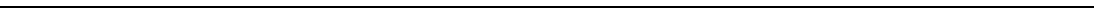
Figure 5 | The AURKA biosensor activates during the G1 phase and at mitosis. ( a ) Representative immunocytochemical images of GFP-AURKA- mCherry U2OS cells synchronized in the indicated cell cycle phases. The fluorescence of EGFP was used to visualize AURKA, centrosomes were labelled with CETN1-iRFP670. N, nucleus. ( b ) Quantification of the fluorescence intensity of EGFP in GFP-AURKA and GFP-AURKA-mCherry cells synchronized in G1 phase, S phase and at mitosis. The fluorescence intensity of both proteins at mitosis was arbitrarily set at 100% and it was used to normalize the fluorescence intensities of EGFP in the other conditions. n ¼ 40–50 cells per condition from three independent experiments. Data represent means ± s.e.m. ( c ) (Left panels) Representative fluorescence (GFP channel) and lifetime images of GFP-AURKA-mCherry cells and (right panel) corresponding quantification of the lifetime of EGFP in GFP-AURKA and GFP-AURKA-mCherry cells synchronized as in a . n ¼ 30–40 cells per condition from three independent experiments. Data represent means ± s.e.m. ( d ) Quantification of the fluorescence recovery of EGFP in GFP-AURKA-mCherry cells synchronized as indicated and subjected to FRAP analysis. n ¼ 30 cells per condition from three independent experiments. Data represent means ± s.e.m. ( e ) Degree of fluorescence recovery of EGFP after 60s from the photobleaching procedure. Scale bar, 10 m m. * P o 0.05, ** P o 0.01 and *** P o 0.001 against the corresponding ‘mitosis’ condition in b , d , the corresponding ‘GFP-AURKA’ condition in c and against the ‘S’ condition in e . a P o 0.001 against the corresponding ‘S’ condition within the GFP-AURKA-mCherry paradigm in c . NS, not significant. Statistical tests: one-way ANOVA in b , d and e ; two-way ANOVA in c